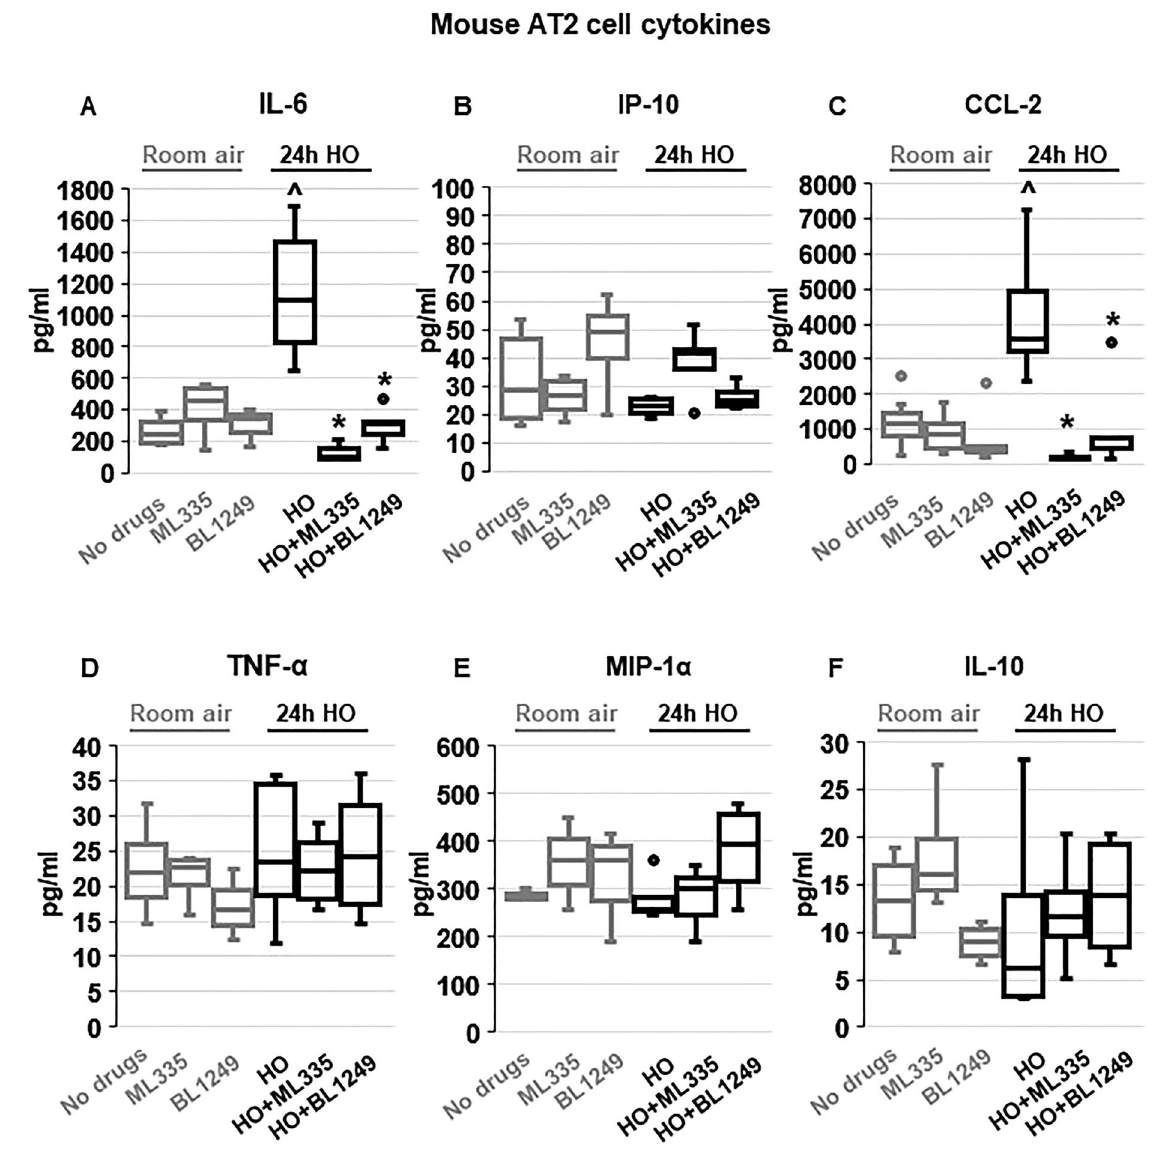
Figure 3. TREK-1 activation with ML335 and BL1249 regulates cytokine secretion from primary mouse AT2 cells: HO exposure increased IL-6 and CCL-2 secretion, which were inhibited by concomitant treatment with ML335 or BL1249 ( A , C ). In contrast, IP-10, TNF-α, MIP-1α and IL-10 levels were not affected by TREK-1 activation in room air- or HO-exposed AT2 cells ( B , D , E , F ). Data are represented as Box-Whisker plots with medians, 1st and 3rd quartiles, and max and min values; n = 5–9; ^compared to cells treated with a vehicle control and exposed to room air (no drugs), *compared to HO exposed cells; p ≤ model, (ii) on inflammatory cytokine secretion, and (iii) on TREK-1 current activation, we used only BL1249 for this part of the study. We found that under room air conditions, activation of TREK-1 channels with BL1249 results in Em hyperpolarization (= a decrease in fluorescence; Fig. 6A) of primary AT2 cells. Similar to the observed activation of TREK-1 currents with BL1249 (Fig. 5), the BL1249-induced Em hyperpolarization also persisted after HO exposure (Fig. 6B). Importantly, these studies also revealed that HO itself causes Em depolari- zation when compared to cells kept at RA, as evidenced by a higher baseline fluorescence value in HO-exposed cells (see RED arrows on the Y-axis → in Fig. 6A, B and summarized in C). TREK‑1 activation decreases intracellular Ca 2+ (iCa) levels during HO exposure. Since inflam- matory cytokine secretion is commonly associated with an increase in iCa concentrations, we used Fluo-4 assays to determine the effects of TREK-1 activation on iCa levels in primary mouse AT2 cells (Fig. 7). Importantly, following 24 h of HO exposure, AT2 cells contained higher iCa concentrations than cells kept at RA (PURPLE arrows on the Y-axis → in Fig. 7A,B and summarized in C). In cells kept at RA, activation of TREK-1 channels